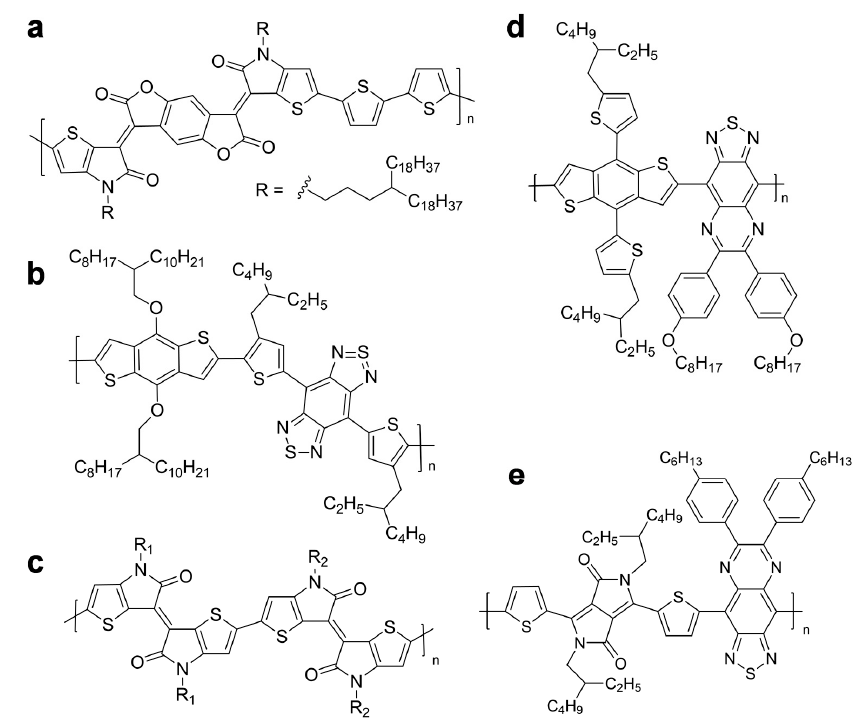
Figure 16. Chemical structures of other semiconducting polymers for NIR-II photoacoustic imaging.